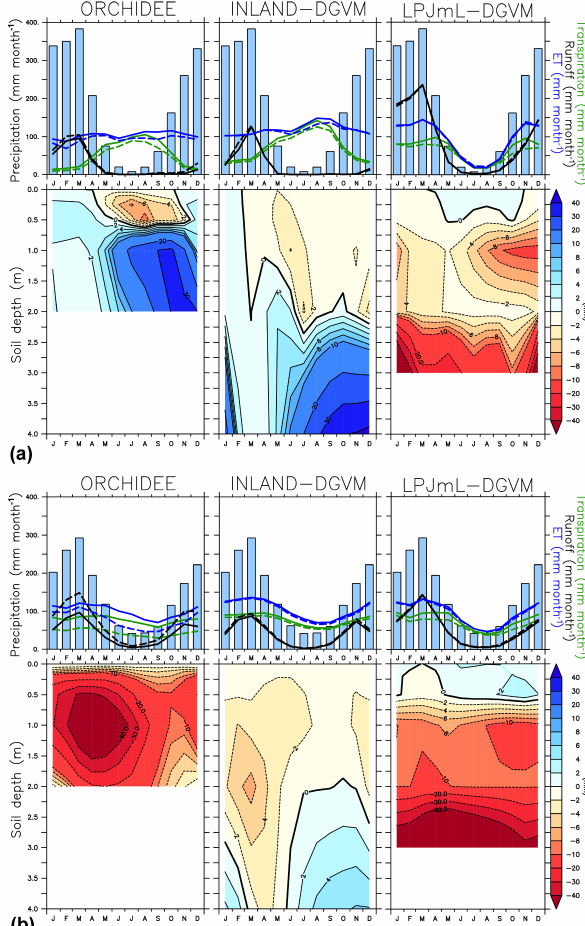
Figure 11. Impact of deforestation combined with climate change on ET (mmmonth − 1 ), transpiration (mmmonth − 1 ), runoff (mmmonth − 1 ) and soil moisture (mm) over the Tapajós catch- ment for the three LSMs for two different end-of-century climates: (a) CCSM3 and (b) UKMO-HadCM3. Top panels show seasonal cycle of precipitation (mmmonth − 1 ) with colour bars and seasonal cycles of ET, transpiration and runoff with plain/dashed lines for NODEF/EXDEF LCC scenarios. Bottom panels show correspond- ing change in soil moisture (mm) due to deforestation combined with climate change. Results for PCM forcing are similar to those for CCSM3 forcing (not